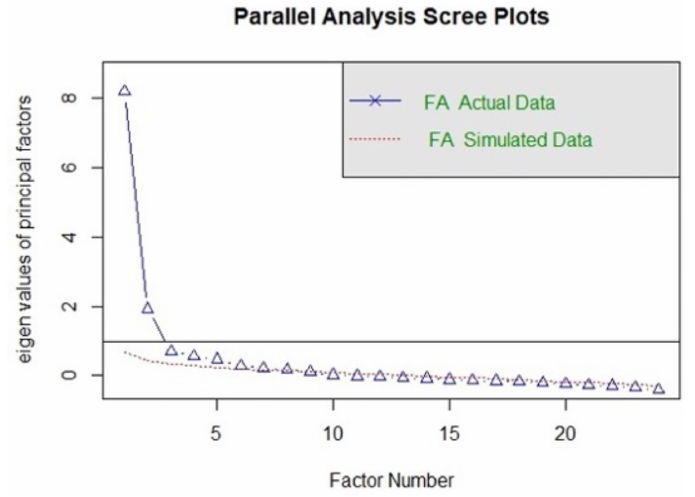
Figure 1. Parallel analysis scree